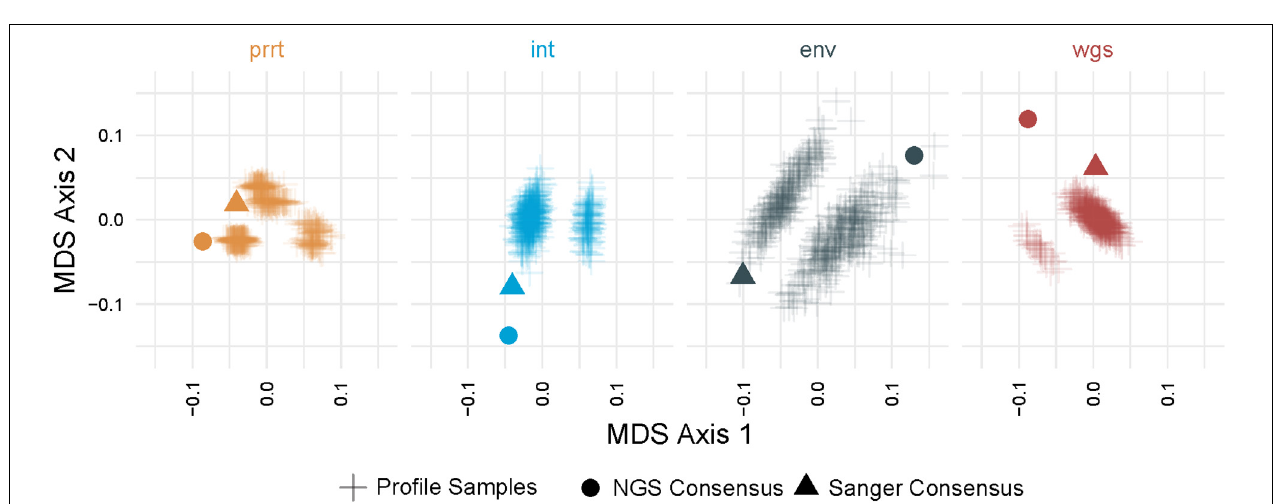
FIGURE 3 | Multi-dimensional scaling (MDS) of pairwise geodesic distance among maximum-likelihood phylogenies from the profile sampling approach within genomic regions. MDS Axis 1 ( X axis) and Axis 2 ( Y axis) show that the space of inferred phylogenies is multi-modal for all genomic regions. The phylogenies from NGS and Sanger consensus sequences (dot and triangle) are point estimates that do not capture the full variation in phylogenies that can be inferred from deeply-sequenced NGS data (plus signs) in all examined genomic regions (colors).